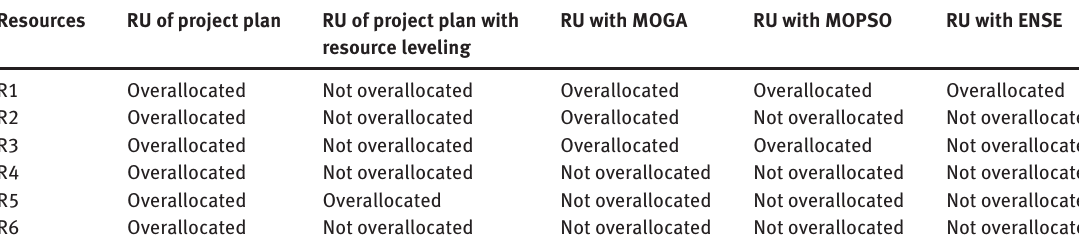
Table 4: Analysis of Optimization Approaches. Resources